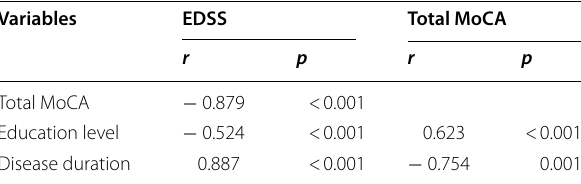
Table 6 Pearson’s correlation between different variables in patients with multiple sclerosis